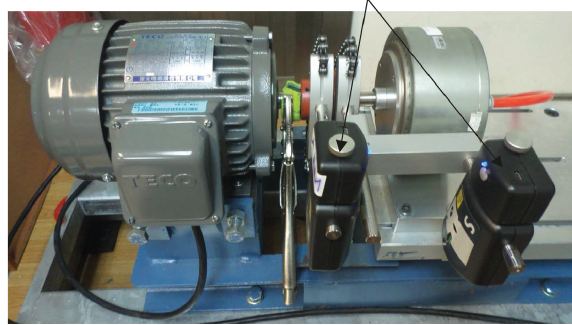
Figure 6: Setup of laser alignment of the shaft.